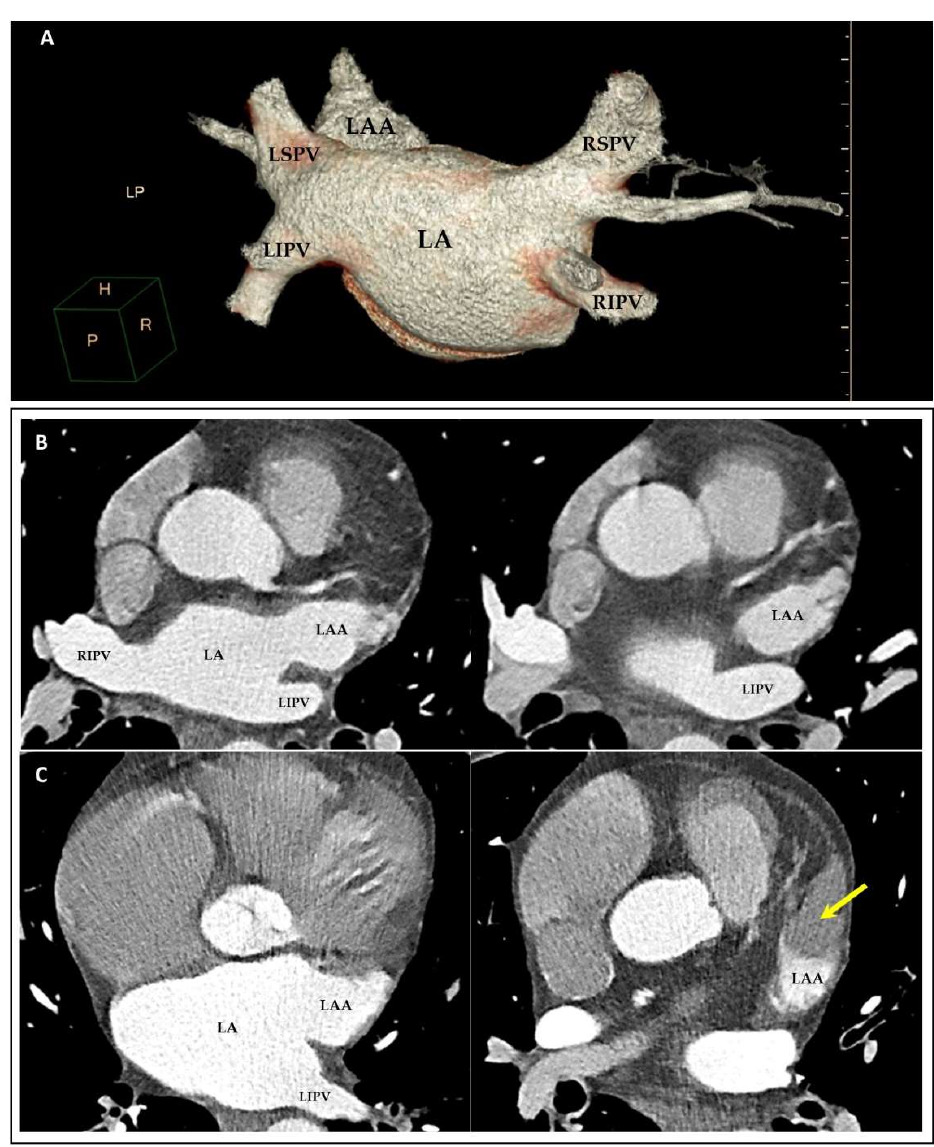
Figure 8. MDCT images focusing on the LA and the anatomical relationships. ( A ) Volume-rendered image showing LA and PVs prior to the performance of PV ablation in AF. ( B , C ) Axial MDCT images depicting LA and LAA prior to its closure. Yellow arrow in ( C ) shows presence of LAA thrombus. LA: left atrium; LAA: left atrial appendage; LIPV: left inferior pulmonary vein; LSPV: left superior pulmonary vein; RIPV: right inferior pulmonary vein; RSPV: right superior pulmonary vein.